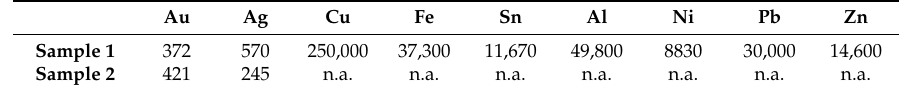
Table 1. Parallel chemical analysis of waste printed circuit board (WPCB) raw material (Samples 1 and 2) used in leaching experiments, element amount presented as mg/kg of WPCB. For Sample 2, only Au and Ag were analyzed (n.a. = not analyzed).